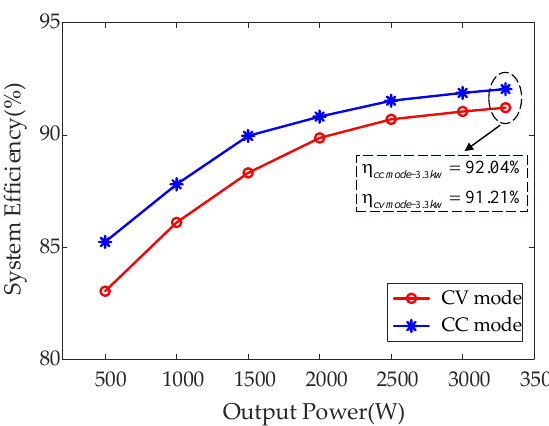
Figure 15. Experimental efficiencies of the IPT system versus output power in both CC and CV output modes.